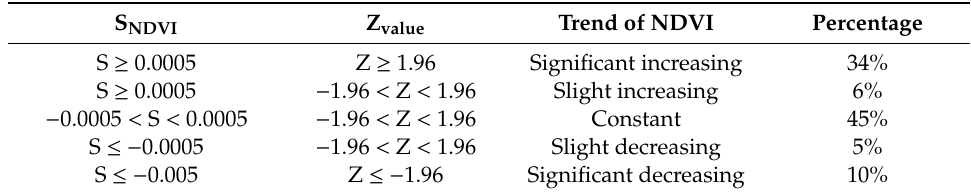
Table 2. The statistics of NDVI trends.